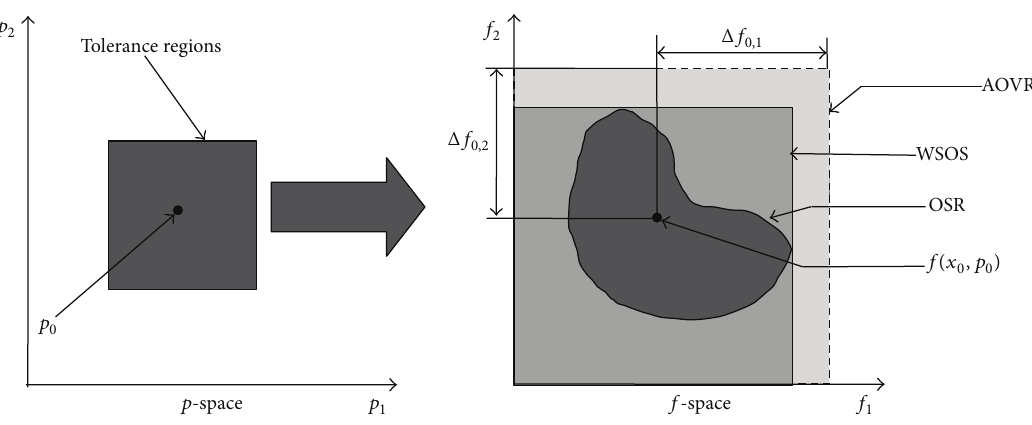
Figure 1: Multiobjective robust optimization